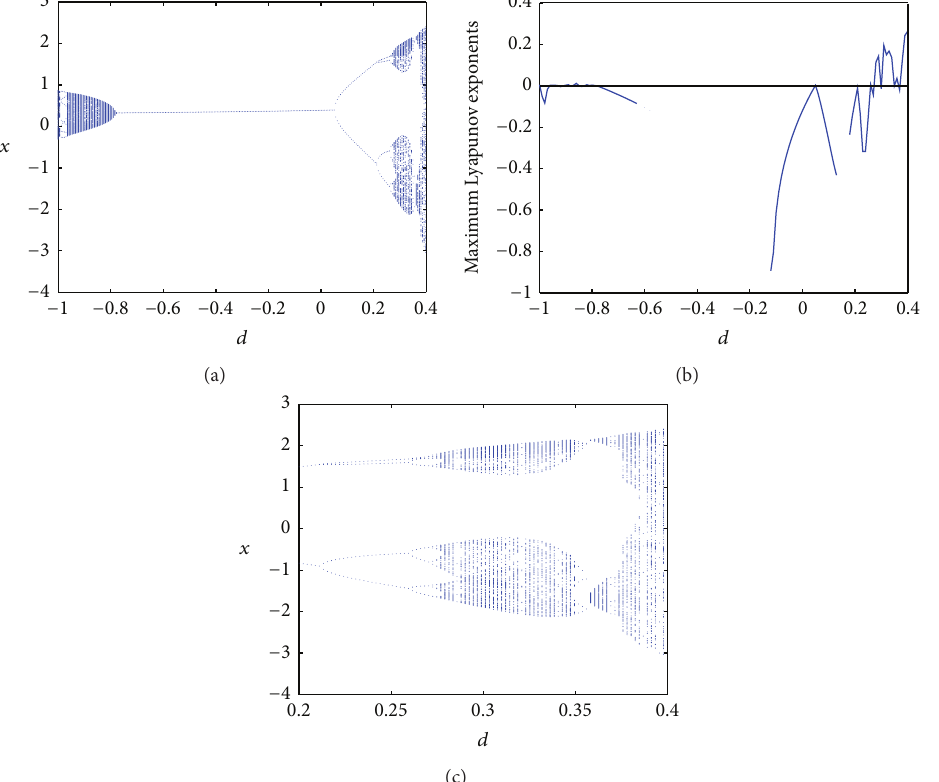
Figure 10: (a) Bifurcation diagram of map (2) in (𝑑, 𝑥) plane for 𝑎 = −0.3 , 𝑏 = 0.9 , 𝑐 = −0.8 , and 𝑒 = 0.5 . (b) Maximum Lyapunov exponents corresponding to (a). (c) Local amplification of